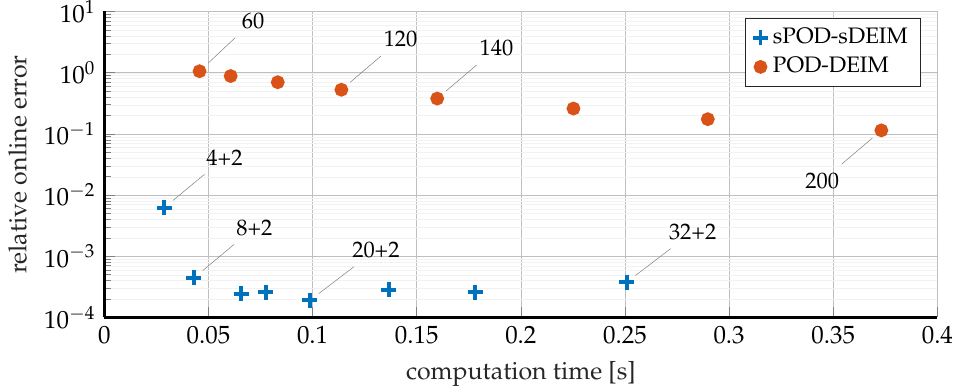
Figure 5. Comparison of computation time and accuracy for β = 558.49 K for different mode numbers: sPOD-sDEIM ROM (blue stars) vs. POD-DEIM ROM (red